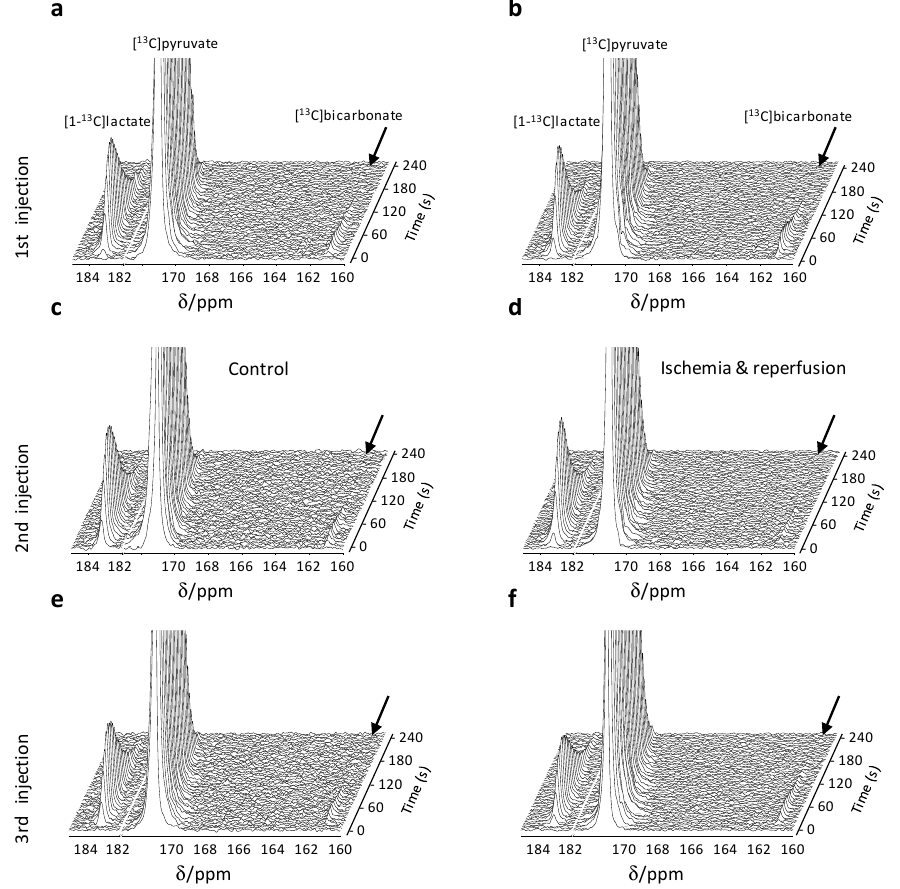
Figure 3. 13 C spectra of hyperpolarized [1- 13 C]pyruvate metabolism in rat brain slices. ( a – f ) Stacked 13 C NMR spectra following injections of hyperpolarized [1- 13 C]pyruvate. ( a – b ) Spectra acquired fol-